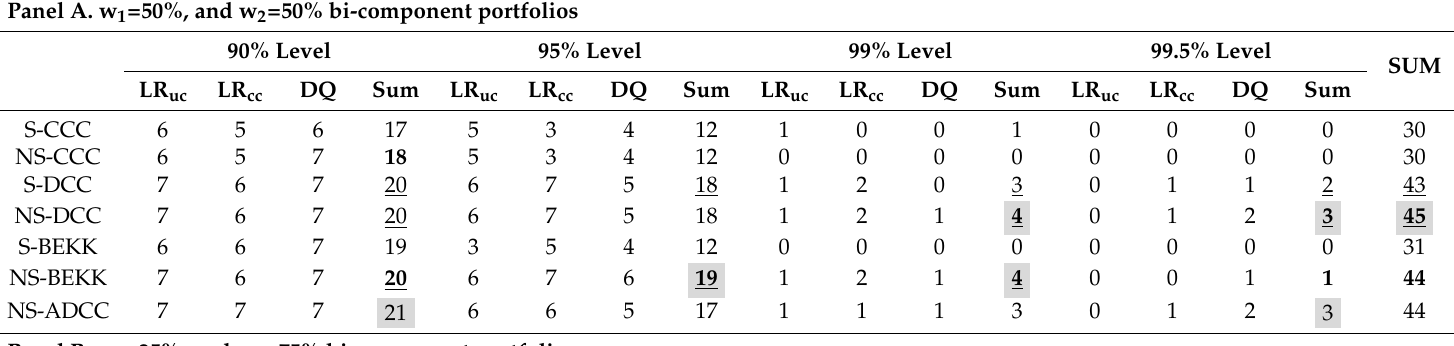
Panel B. w 1 =25%, and w 2 =75% bi-component